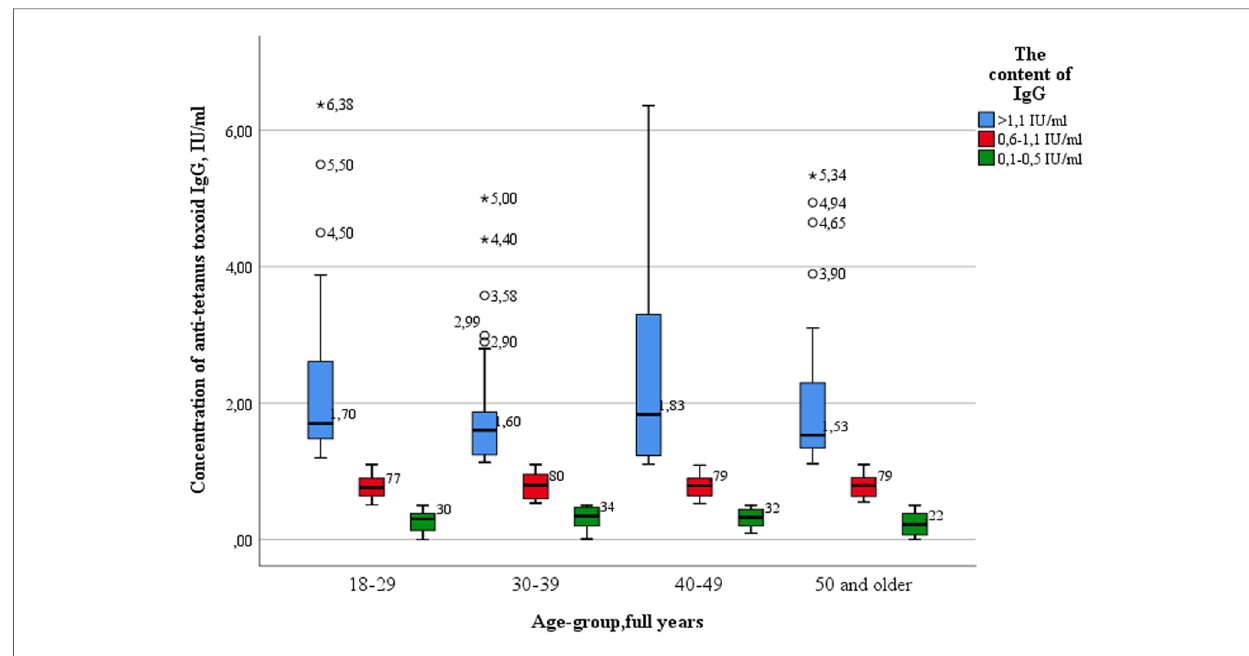
FIGURE 5 The level of tetanus immunity in different age groups of healthcare professionals.